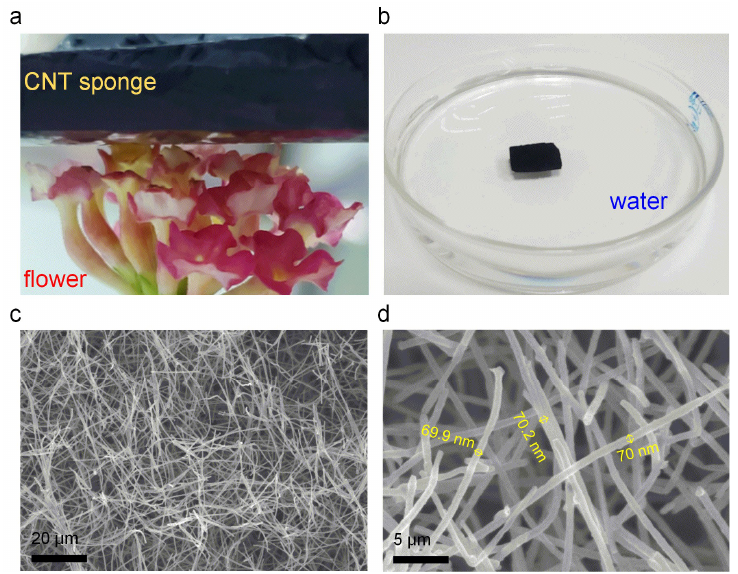
Figure 2. ( a ) Photograph of 3D CNTs sponge placed on top of a flower. ( b ) Photograph of 3D CNTs sponge on the water. ( c,d ) SEM photographs of the CNTs sponge comprising CNTs. The CNTs are ~70 nm in diameter.